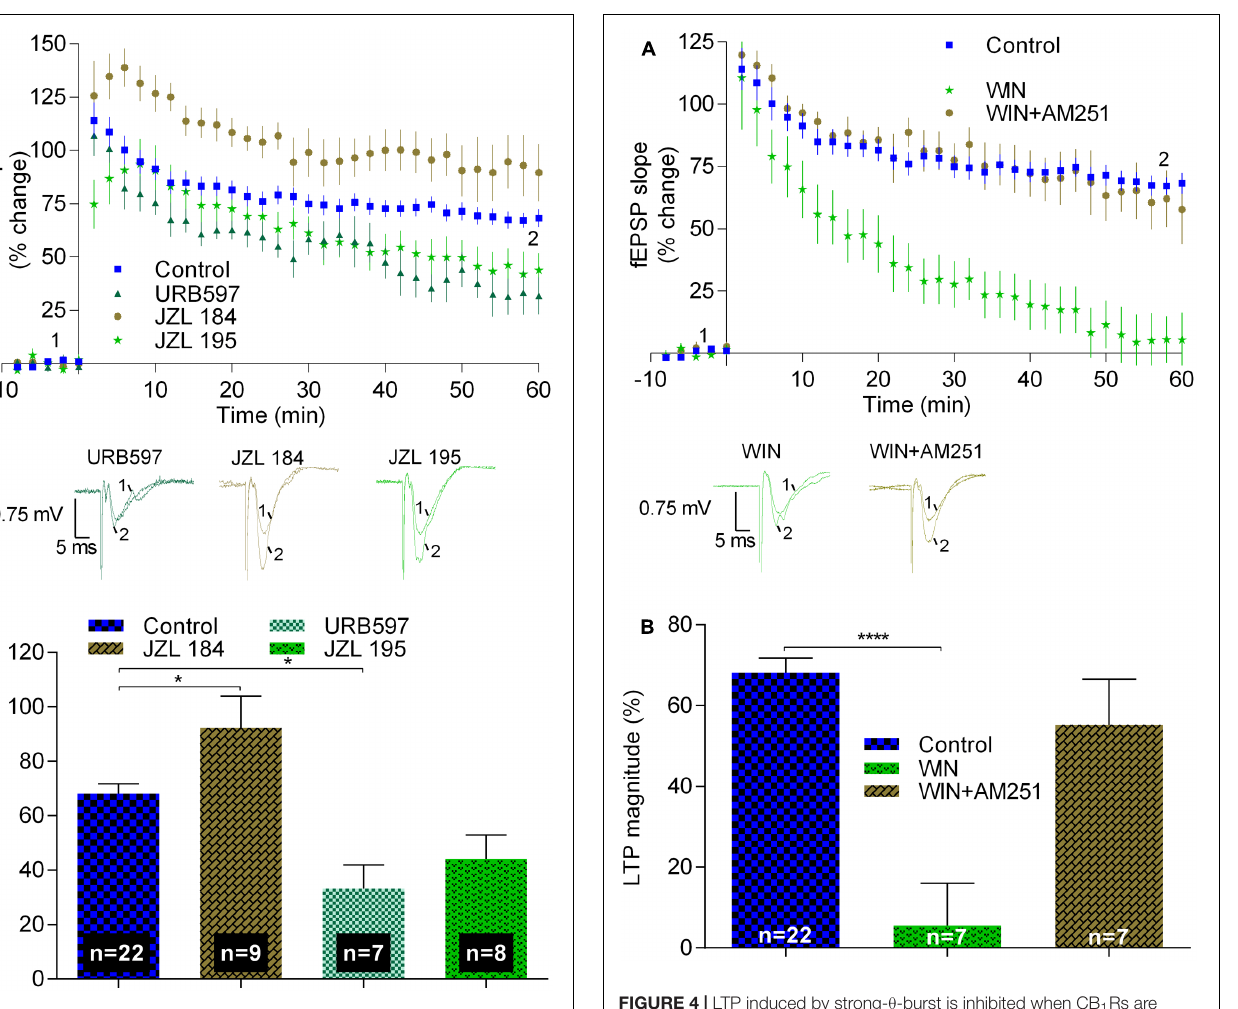
FIGURE 3 | Inhibitors of the hydrolysis of 2-AG or of anandamide differently affect strong- θ -burst induced LTP. (A) Time course of the averaged fEPSP slopes, and original traces of fEPSP recordings, in control conditions (no drugs) or in the presence of 1 µ M JZL 184 (inhibitor of the enzyme that hydrolyses 2-AG, MAGL), 1 µ M URB597 (inhibitor of the enzyme that hydrolyses anandamide, FAAH), or in the presence of 1 µ M JZL 195 (inhibitor of FAAH and MAGL). (B) Quantification of LTP magnitude under the indicated drug conditions. Data in control conditions, in panels (A) and (B) , are the same as shown in Figures 2A,B , but are represented in this figure to allow comparison with the drug conditions. ∗ p < 0.05 ( F ( 3 , 42 ) = 10.3, one-way ANOVA with Sidak’s correction). For further details see legend to Figure 1 .